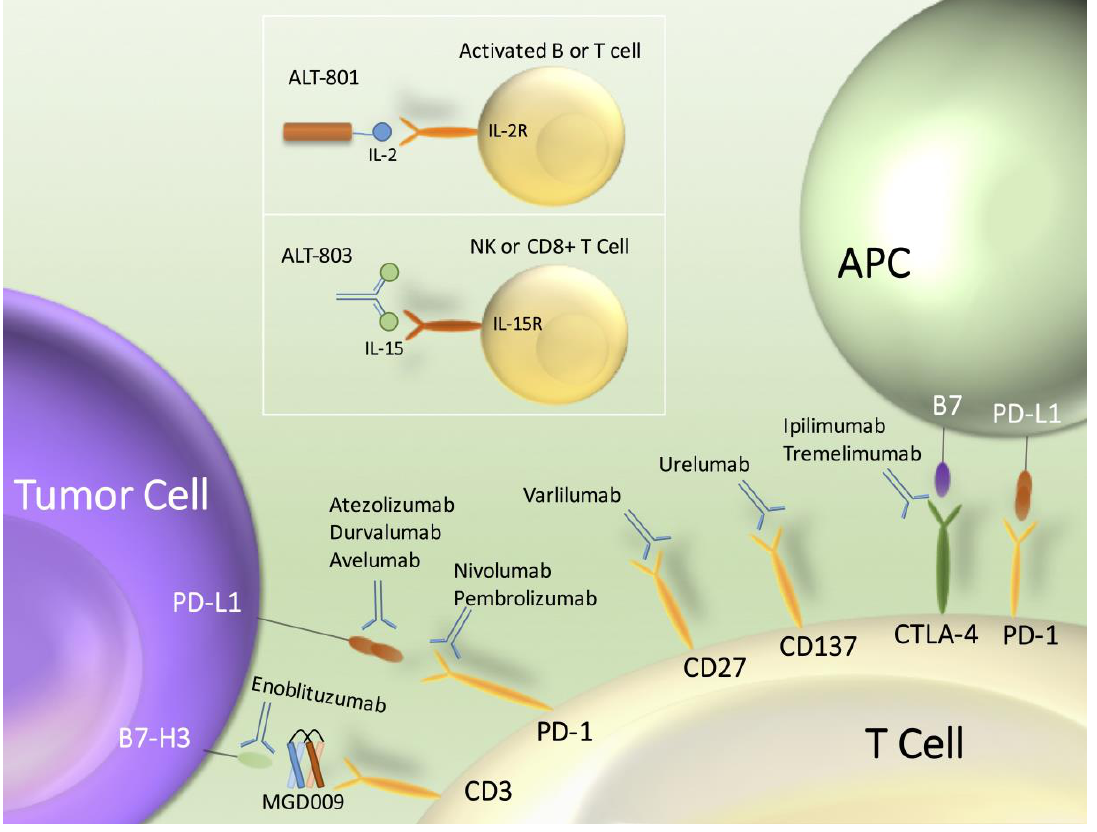
Figure 1. Checkpoint inhibitors, interleukin stimulators and novel immunotherapy agents in urothelial carcinoma.